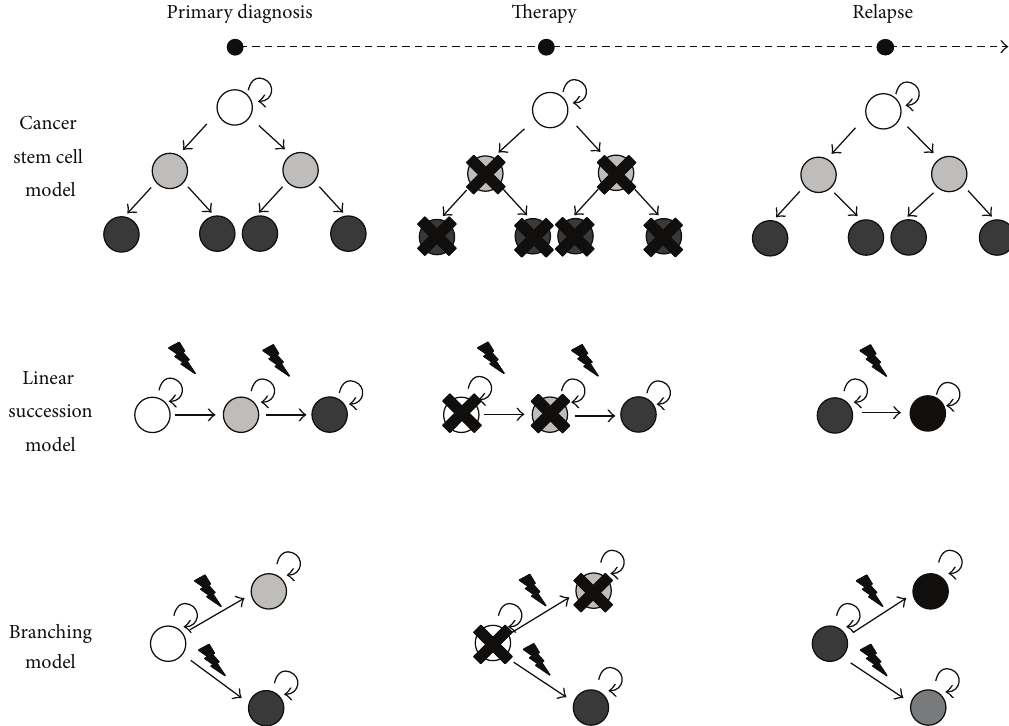
Figure 2: Treatment escape leading to relapse in the stem cell and clonal evolution models. In the cancer stem cell model, all leukemic bulk cells are eradicated by therapy, apart from stem cell-like LICs, which are resistant to therapy and give rise to relapse. In the clonal evolution model,distinctsubclonesacquirethecapabilityoftherapyresistancebyongoingmutations.Subclonesthatwerenoteradicatedduringtherapy provide then the leukemic reservoir for